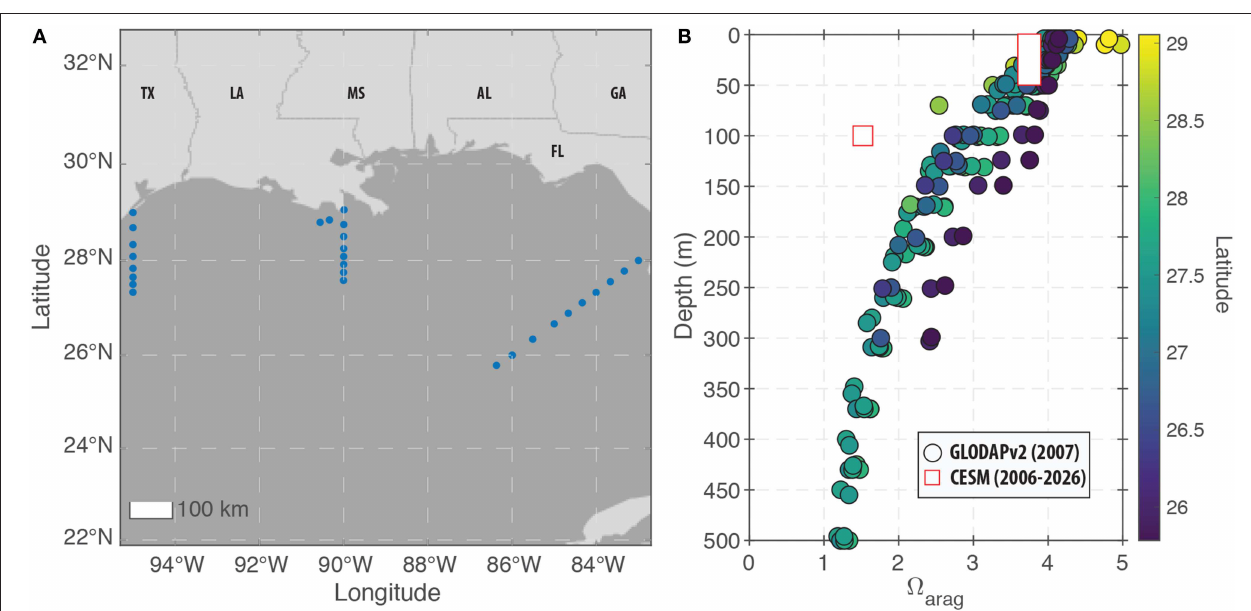
FIGURE 6 | Simulated changes in GoM salinity in the RCP8.5 Large Ensemble, CESM1.2. (A) 2080–2100 mean. (B) (2080–2100) mean minus (2006–2026) mean. Continental regions are shown in white.